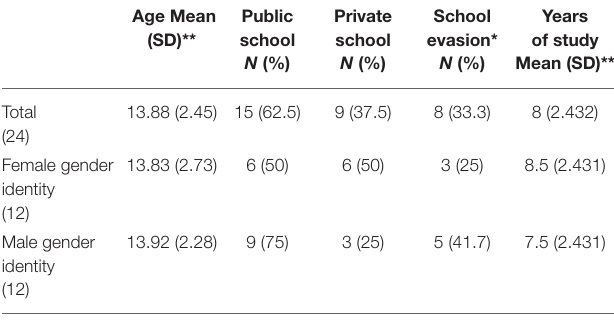
TABLE 1 | Sociodemographic data referring to the studied youth